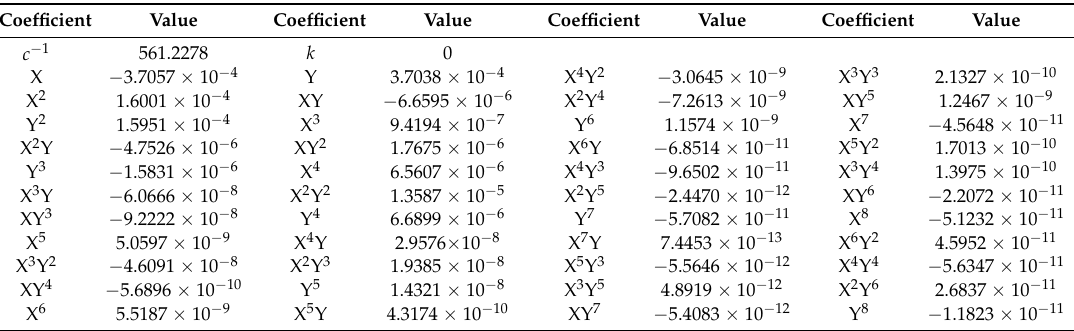
Figure 8. ( a ) Ge freeform surface sag map with machining tool path and ( b ) distribution of fluctuation in the sagittal direction ∆ d . Table 3. Coefficients of x and y in the XYP extension polynomial.